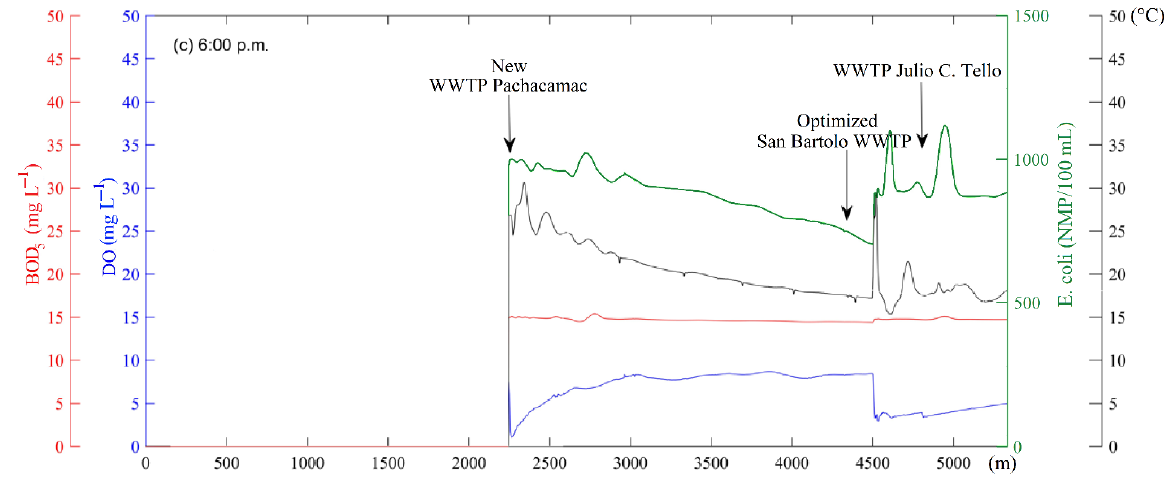
Figure 7. Longitudinal profile of river recovery according to DO , BOD 5 , E. coli, and T (from L5 to L1): 6 a.m. ( a ), 12 m. ( b ) and 6 p.m. ( c ). Red line is BOD 5 , blue line is DO , green line is E. coli , and black line is T .